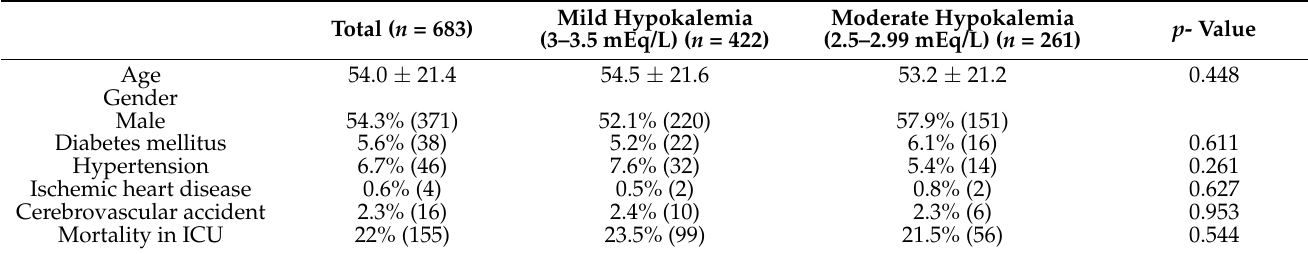
Table 1. Baseline characteristics of patients treated for hypokalemia. Total ( n = 683)